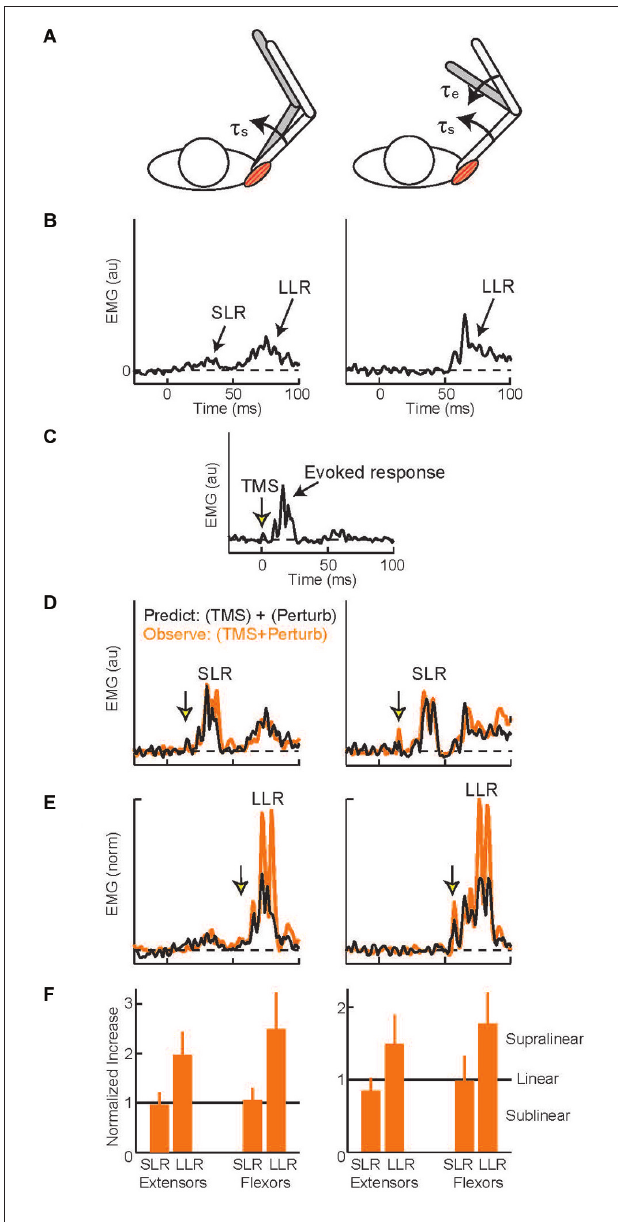
FIGURE 5 | Evoked muscle activity to perturbation torques and transcranial magnetic stimulation . (A) Torque perturbations applied to the arm, a shoulder flexion torque which displaced the shoulder joint (left cartoon) and shoulder + elbow flexion torque which only displaced the elbow (right cartoon). (B) Evoked activity of the shoulder extensor muscle during shoulder displacement (left panel) and pure elbow displacement (right panel), 0 ms is perturbation onset. Data from a representative subject (C) Evoked activity in the shoulder extensor to a single TMS pulse, 0 ms is TMS onset. (D) TMS pulse timed to occur during the SLR with shoulder displacement (left panel) and pure elbow displacement (right panel). Orange trace is the observed muscle activity to the combined stimulus; black trace is the predicted response, summed activity to the separate perturbation and TMS stimuli. (E) TMS pulse timed to occur during the LLR. Same format as above. (F) Group data for the two shoulder muscles. Data normalized to predicted response so values equal to 1 equal linearity whereas values above 1 indicate superlinearity and evidence of a common cortical circuit. Figure modified with permission from Pruszynski et al.